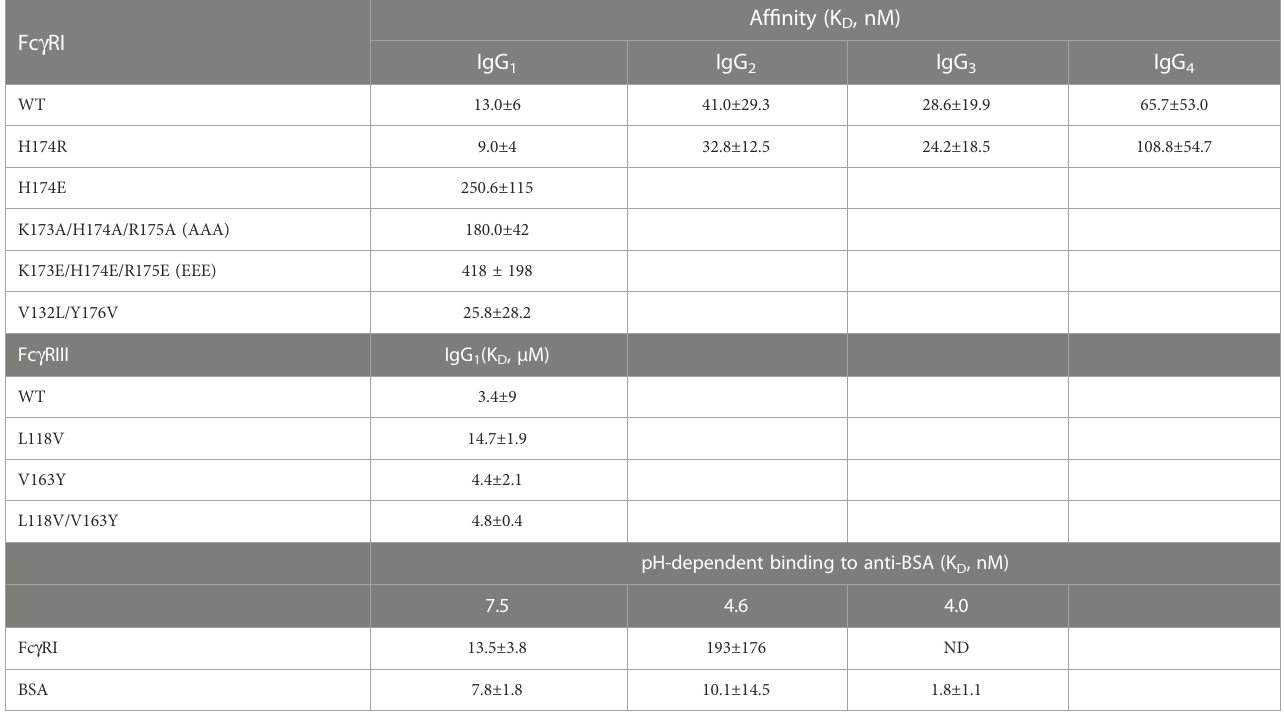
TABLE 1 Dissociation constants for Fc g R binding to